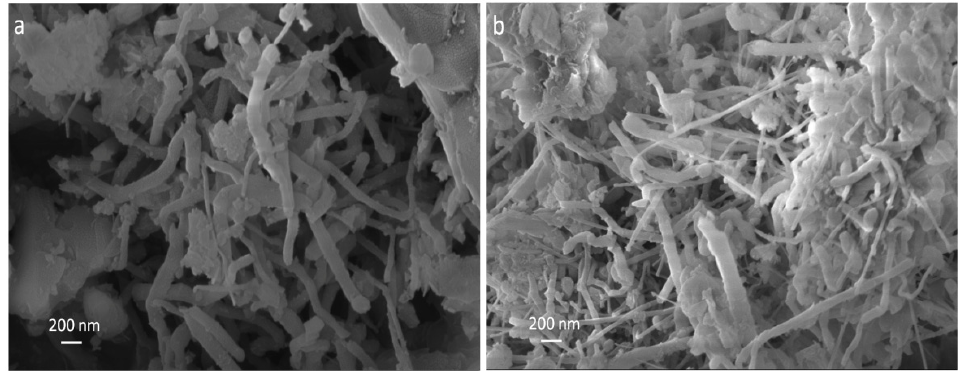
Figure 7. SEM images of BNNTs ( a ) and Cu-BNNTs ( b ).